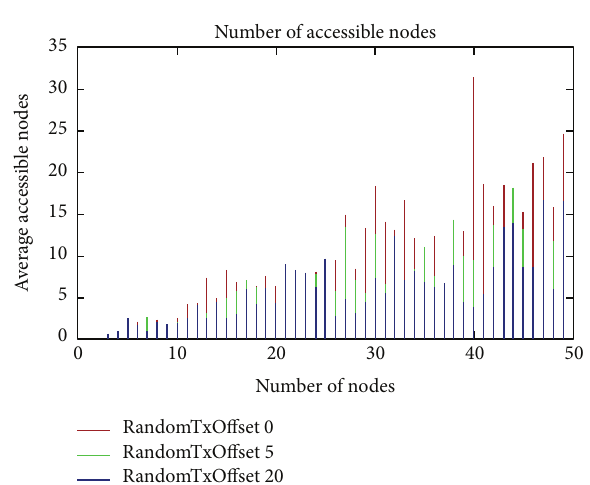
Figure 15: RandomTxOffset.